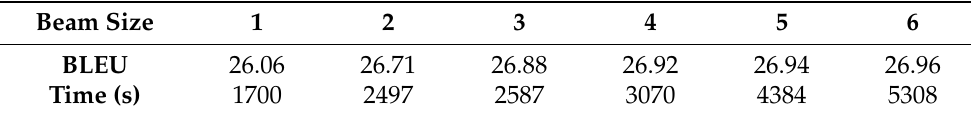
Figure 8. The test BLEU and relative test time (relative to beam size=1). Table 4. The test BLEU and test time based on different beam sizes.